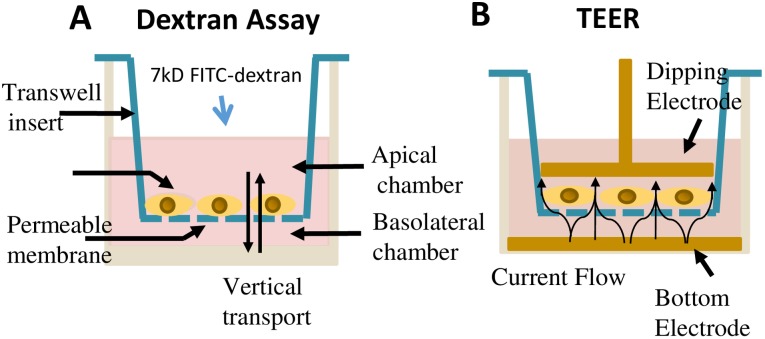
Schematic description of transendothelial permeability assays.(A) Diagram depicting method for Dextran assay protocol. (B) Diagram depicting the measurement using the TEER protocol.